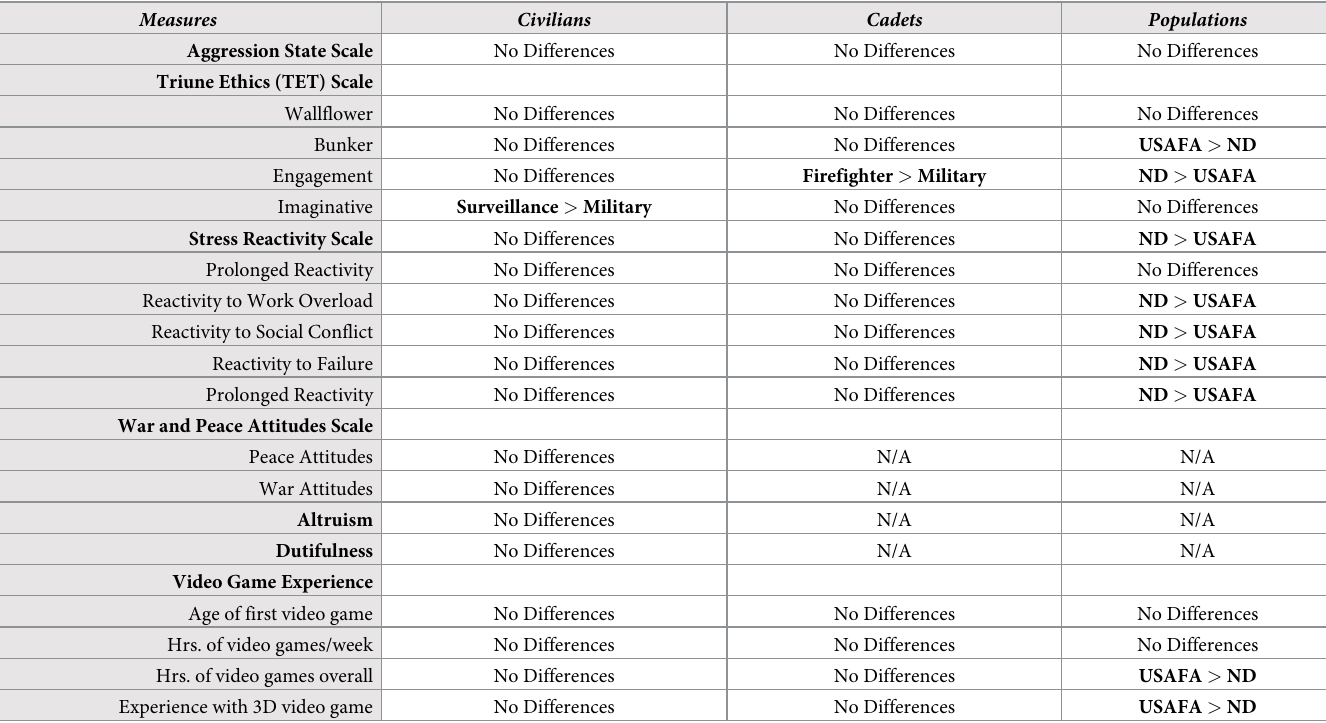
Table 2. The baseline measures used with both